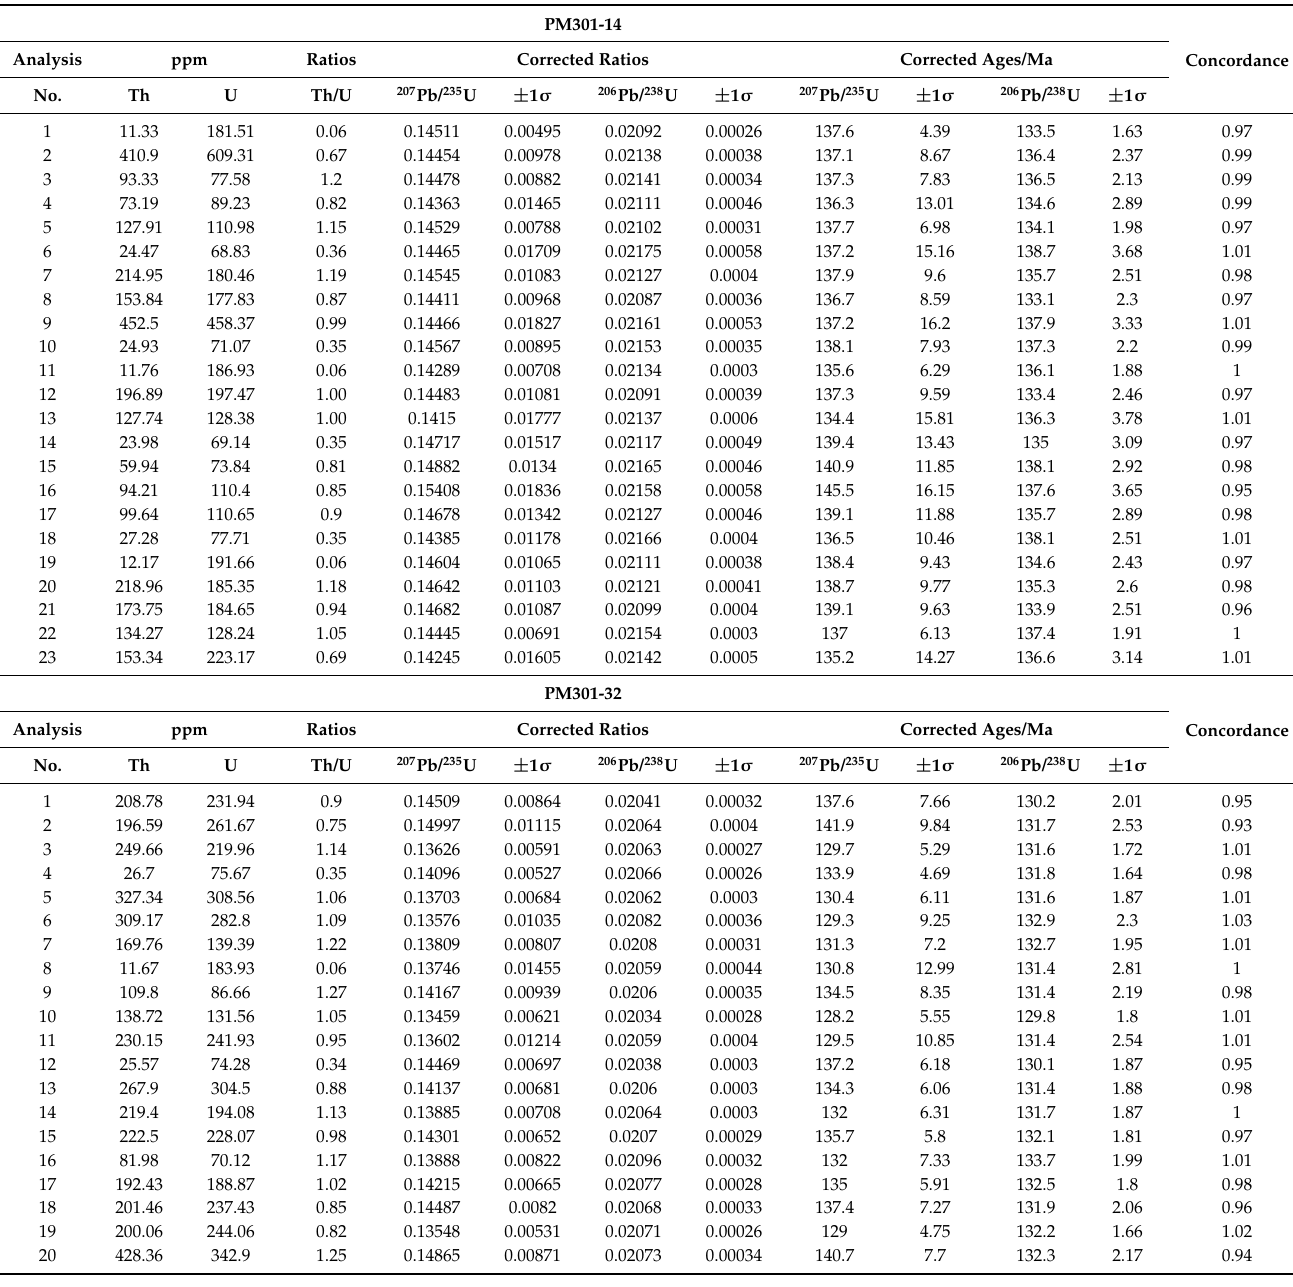
Table 2. LA-ICP-MS U-Pb analytical data for zircon from rhyolite tuff (sample PM301-14